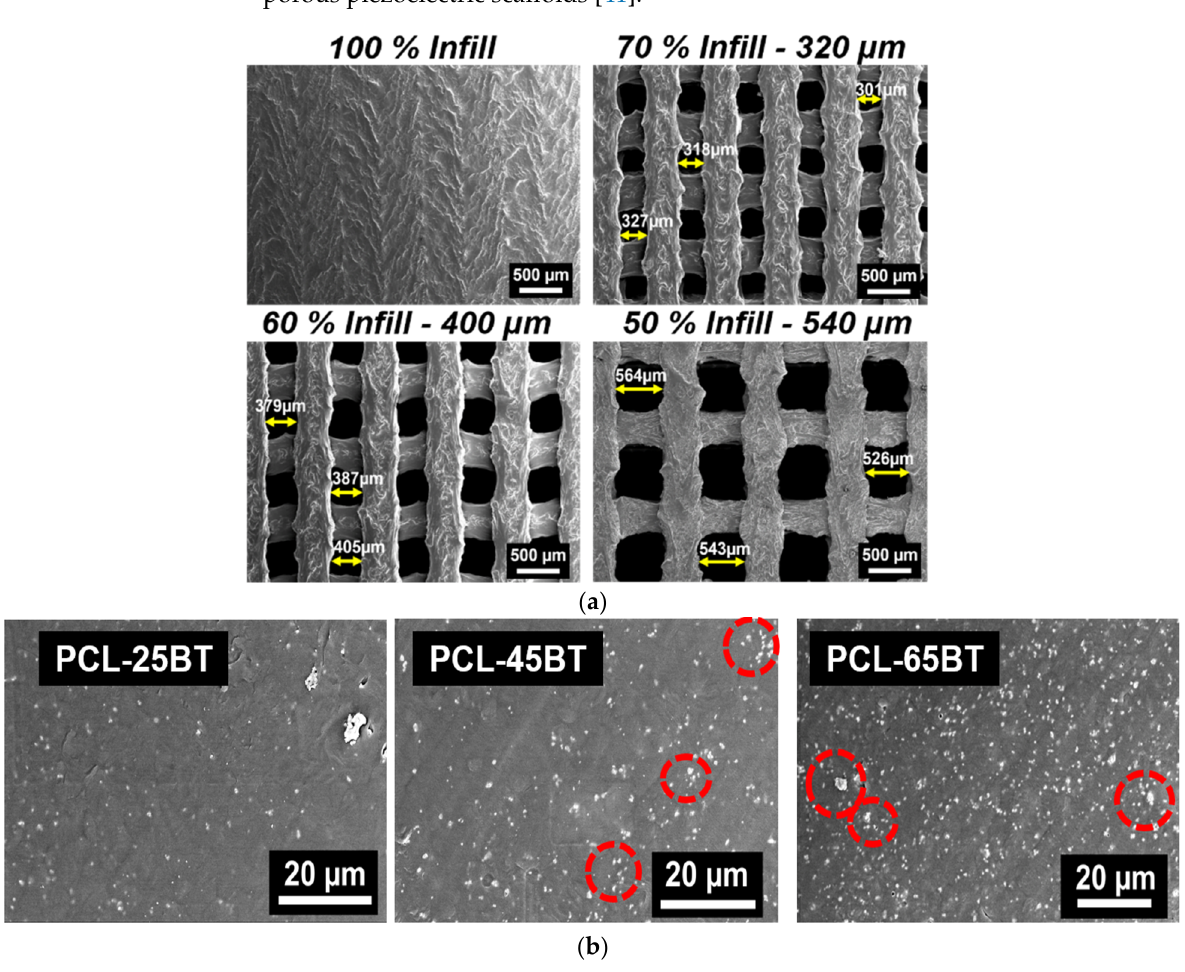
Figure 7. SEM analysis of the scaffolds using secondary electron detector. ( a ) SEM of the non-porous and porous 3D-printed PCL-45BT scaffolds. The pore sizes of the scaffolds were varied by changing the infill percentage in the slicing software. ( b ) SEM of various PCL-BT filament cross-sections showing the uniform dispersion of the white BaTiO 3 particles in the PCL matrix.